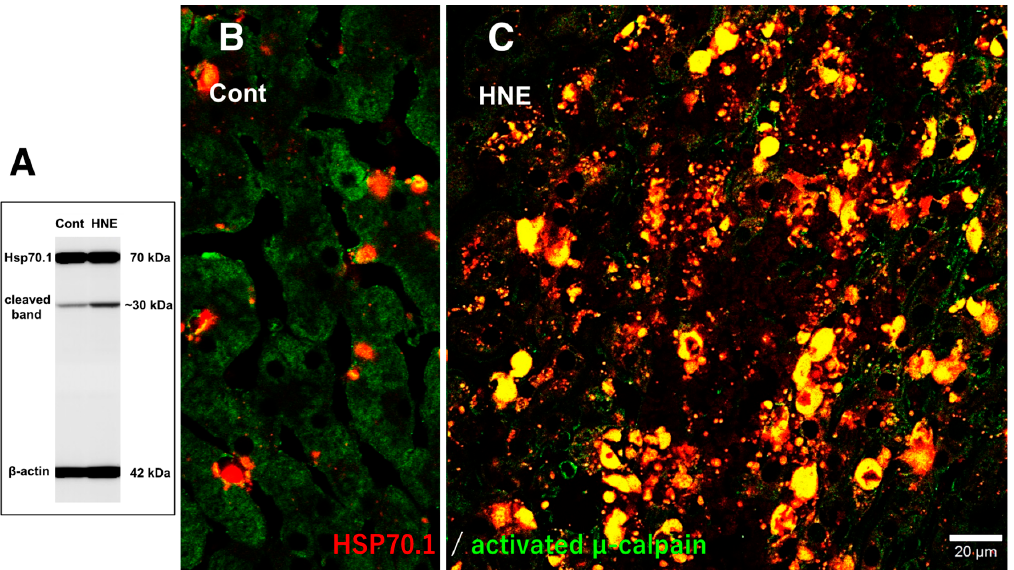
Figure 7. Western blotting ( A ) and immunohistochemical ( B , C ) data for the samples with (HNE) and without (Cont) the hydroxynonenal (HNE) injections. The Western blotting analysis indicates that the calpain-mediated cleavage of Hsp70.1 was increased after the hydroxynonenal injections (HNE), compared to the control (Cont). The immunohistochemical analysis indicates that activated μ -calpain (green) interacted with Hsp70.1 (red), especially after the hydroxynonenal injections (HNE).